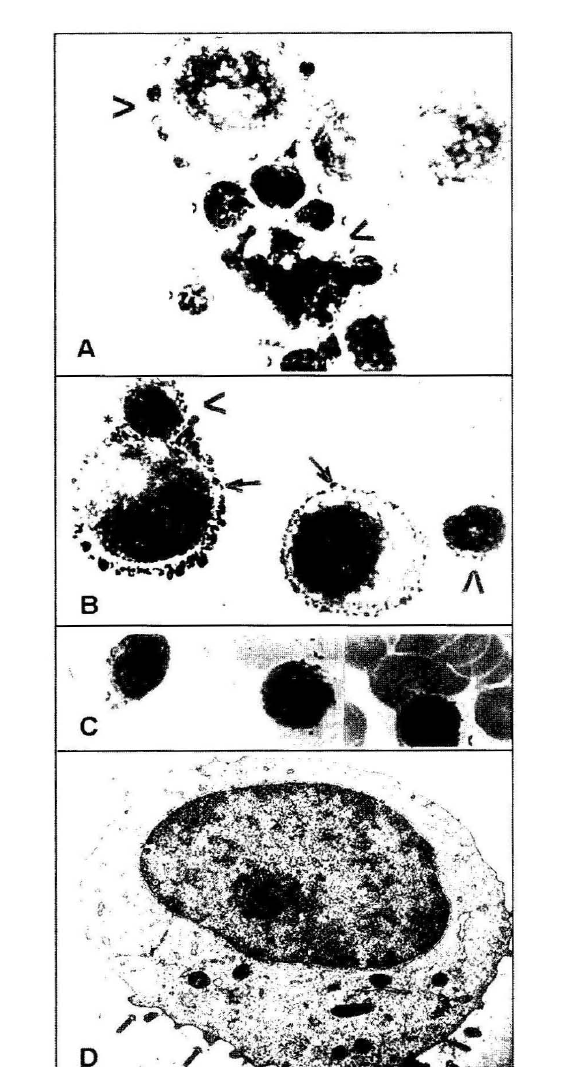
figure 8. A: Cancer cells (arrowheads) and small lym phocytes (small arrowheads) interrelationships: small lymphocytes forming rosette-like strucrure around one tumor cell; B: cancer cells (arrows), small lymphocytes (arrowheads) and their relationships on the level of cytoplasmic RNP (*) which are unstained in places of cell to cell contacts (a possible influence of integrins or other biologically active substances on the cell membranes per meability could be disscussed-Zvetkova et al., unpublished). Cytological smears, stained by the method of Zvetkova and Zvetkov, ref. 99 (x600); C: small lymphocytes fi-om the peripheral blood of tumor-bearing animals, with reduction of cytoplasmic Rl'lP, by clasmatoses (arrowheads); blood smears stained by the same method (x600) D: c1ectronograms of cancer-patient lymphocytes with abundant ribosomes-containing clasmatoses (arrows) at the cytoplasm periphery (Opron electron microscope,